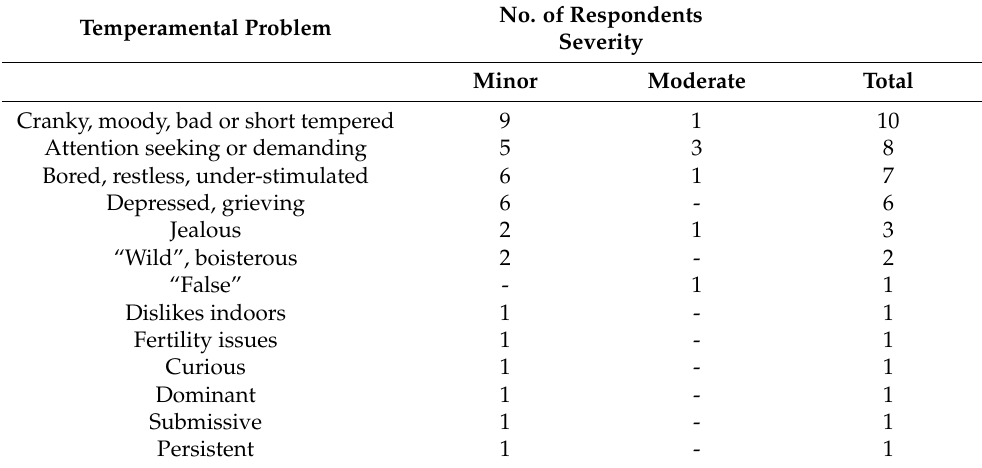
Table 3. The distribution of the perceived temperamental problems, directly translated and suggested answers of the respondents ( n = 43) reporting only issues with their cat’s temperament. Temperamental